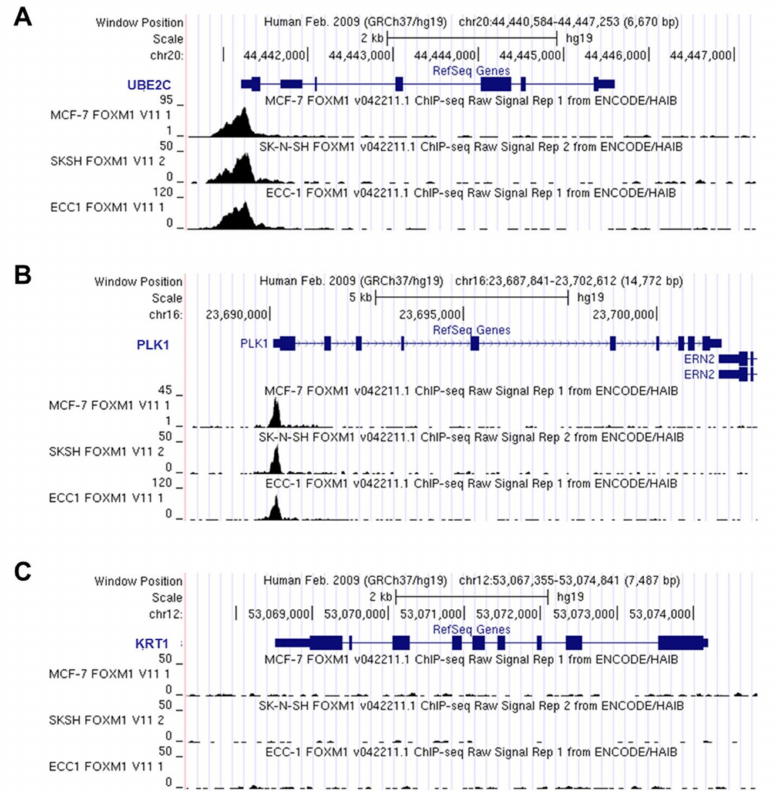
Figure 4. FOXM1 binds to UBE2C promoter region. Re-analysis of FOXM1 ChIP-seq data available in ENCODE-USCC platform. FOXM1 chromatin immunoprecipitation was performed in three different human cancer-derived cell lines: MCF-7 (breast cancer derived), ECC1 (endometrial adenocarcinoma derived) and SKSH (neuroblastoma derived), and the presence of DNA peaks were evaluated in UBE2C ( A ); PLK1 ( B ) and KRT1 ( C ) promoter regions; ( A ) DNA peaks were detected in the region corresponding to UBE2C promoter, following FOXM1 immunoprecipitation, in the three cell lines investigated; ( B ) DNA peaks were also detected in the region corresponding to PLK1 promoter, evaluated as a positive control for FOXM1 binding; ( C ) Absence of DNA peaks in the region comprising KRT1 promoter, evaluated as a negative control for FOXM1